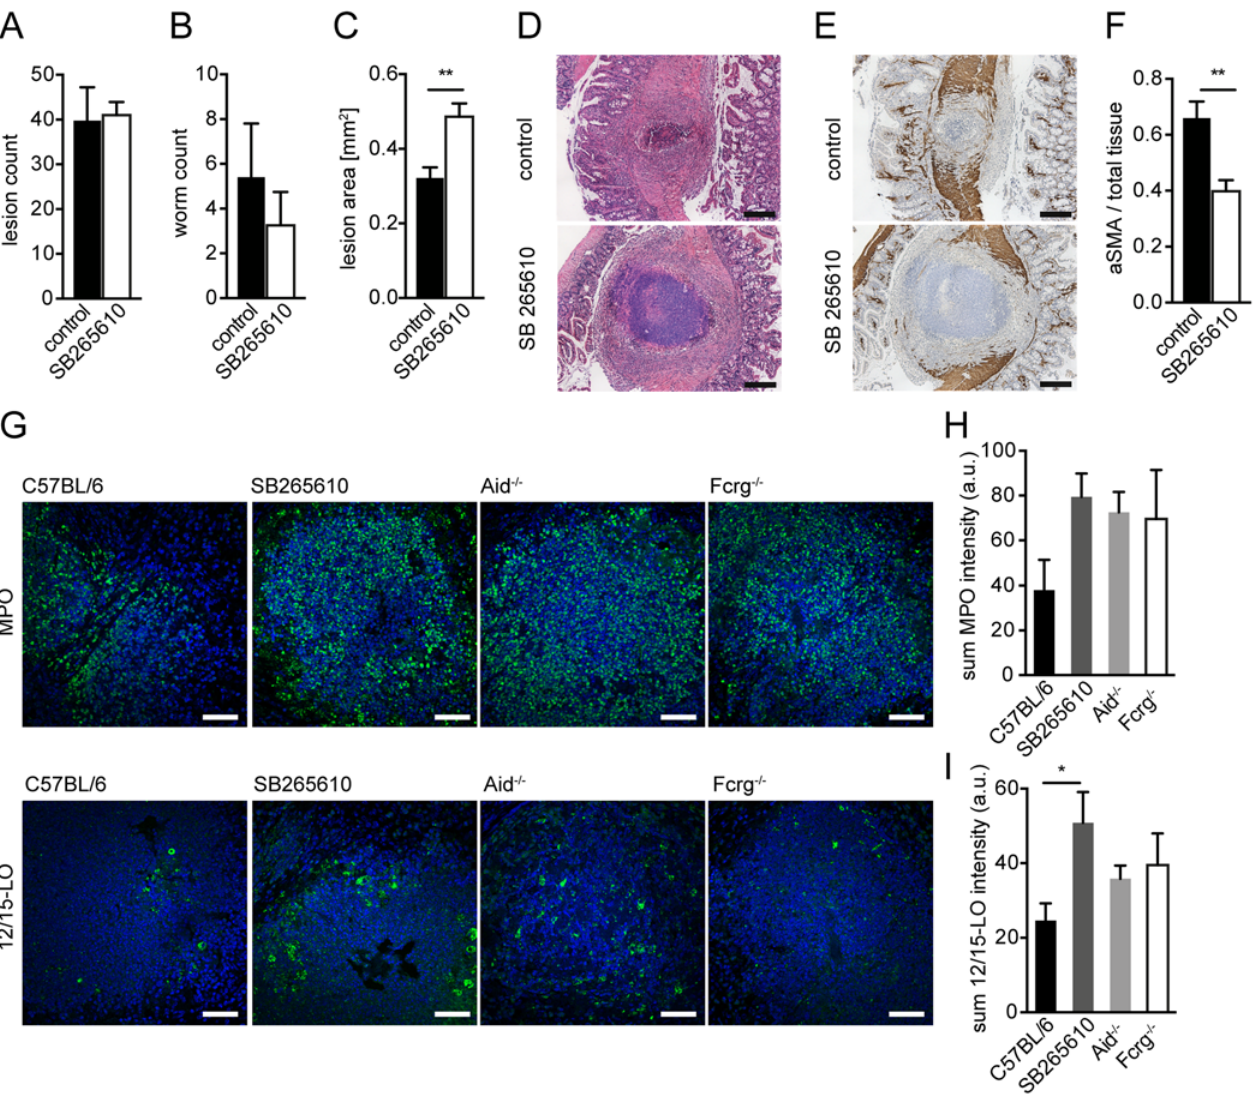
Fig 4. Inhibition of CXCR2 signaling leads to delayed MF accumulation and increased lesion size without affecting granulocyte recruitment in vivo. C57BL/6 mice were treated or not with the CXCR2 antagonist SB265610 (3 mg/kg per oral gavage, once daily) during challenge infection with Hpb ; small intestines were harvested for parasitology and histology at day 14 p.i. (A) Lesions were counted in small intestines of untreated (control) and SB265610 treated mice; (B) Adult worms were counted in opened small intestines of untreated (control) and SB265610 treated mice; (C) The area of the largest lesion cross sections was quantified in H&E-stained tissue sections from untreated (control) and SB265610 treated mice; (D) Representative H&E-stained cross sections of intestinal lesions in untreated (control) and SB265610 treated mice; Scale bars 200 μ m. (E) Representative IHC-staining for aSMA in lesions of untreated (control) and SB265610 treated mice; Scale bars 200 μ m. (F) Quantification of aSMA-stained area in lesions of untreated (control) and SB265610 treated mice was performed using ImageJ; (G) Small intestinal tissue sections from challenge-infected untreated C57BL/6 (control) and SB265610